Question: Express in one sentence what the figure is showing.
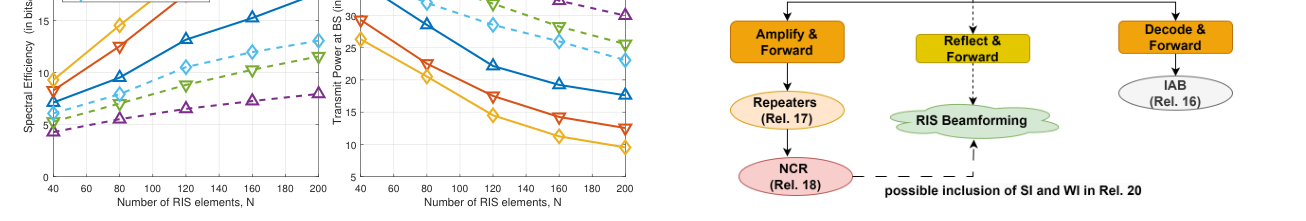
Answer: Performance Evaluation of RIS-aided RSMA when the minimum QoS rate requirement = 1bps/Hz, number of users = 6, number of BS antennas = 4, maximum transmit power budget = 40dBm.